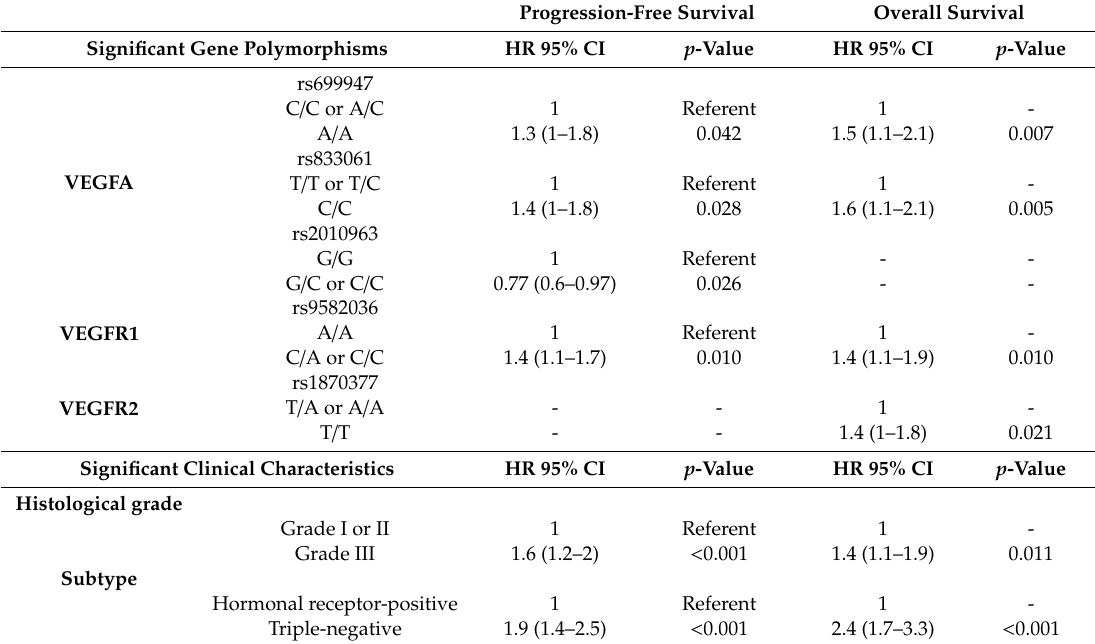
Table 2. Univariate analysis for the polymorphisms and clinical characteristics according to progression-free survival (PFS) and overall survival